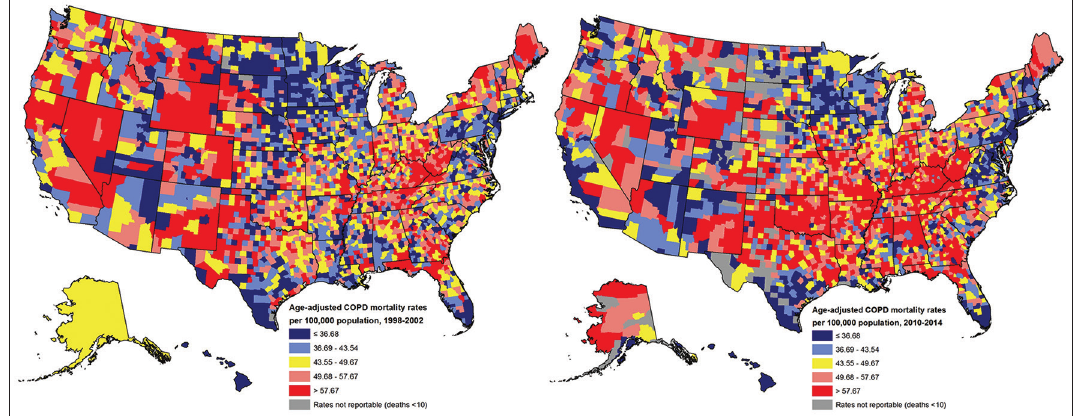
Fig ure 17. Age-Adjusted COPD Mortality Rates per 100,000 Population for the United States (3,143 Counties), 1998- 2002 and 2010-2014 Source: Derived from the 1998-2014 National Vital Statistics